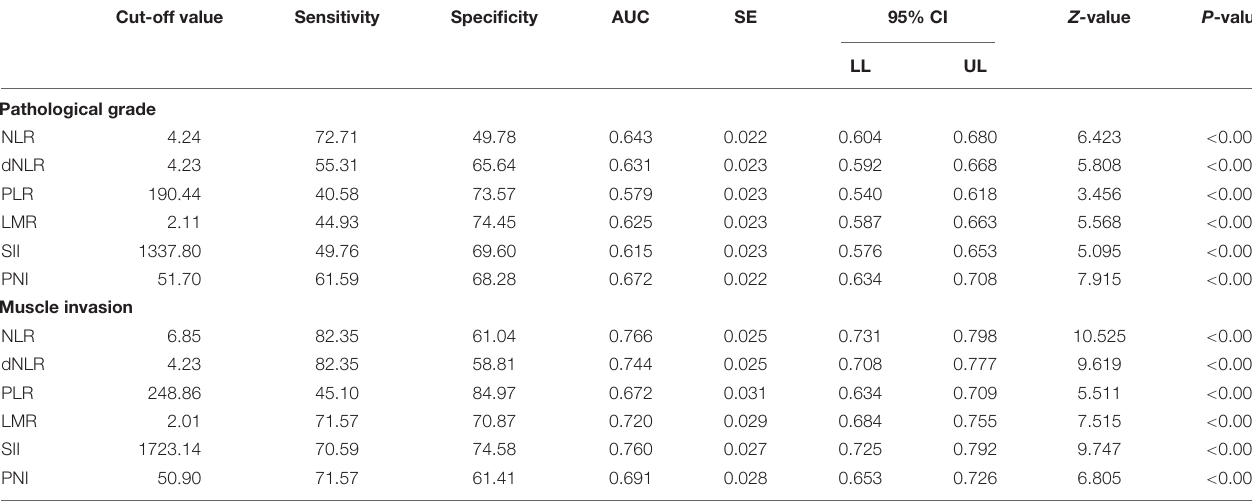
TABLE 3 | The Area Under Curve and cut-off values of the inflammatory factors for pathological grade and muscle invasion. Cut-off value